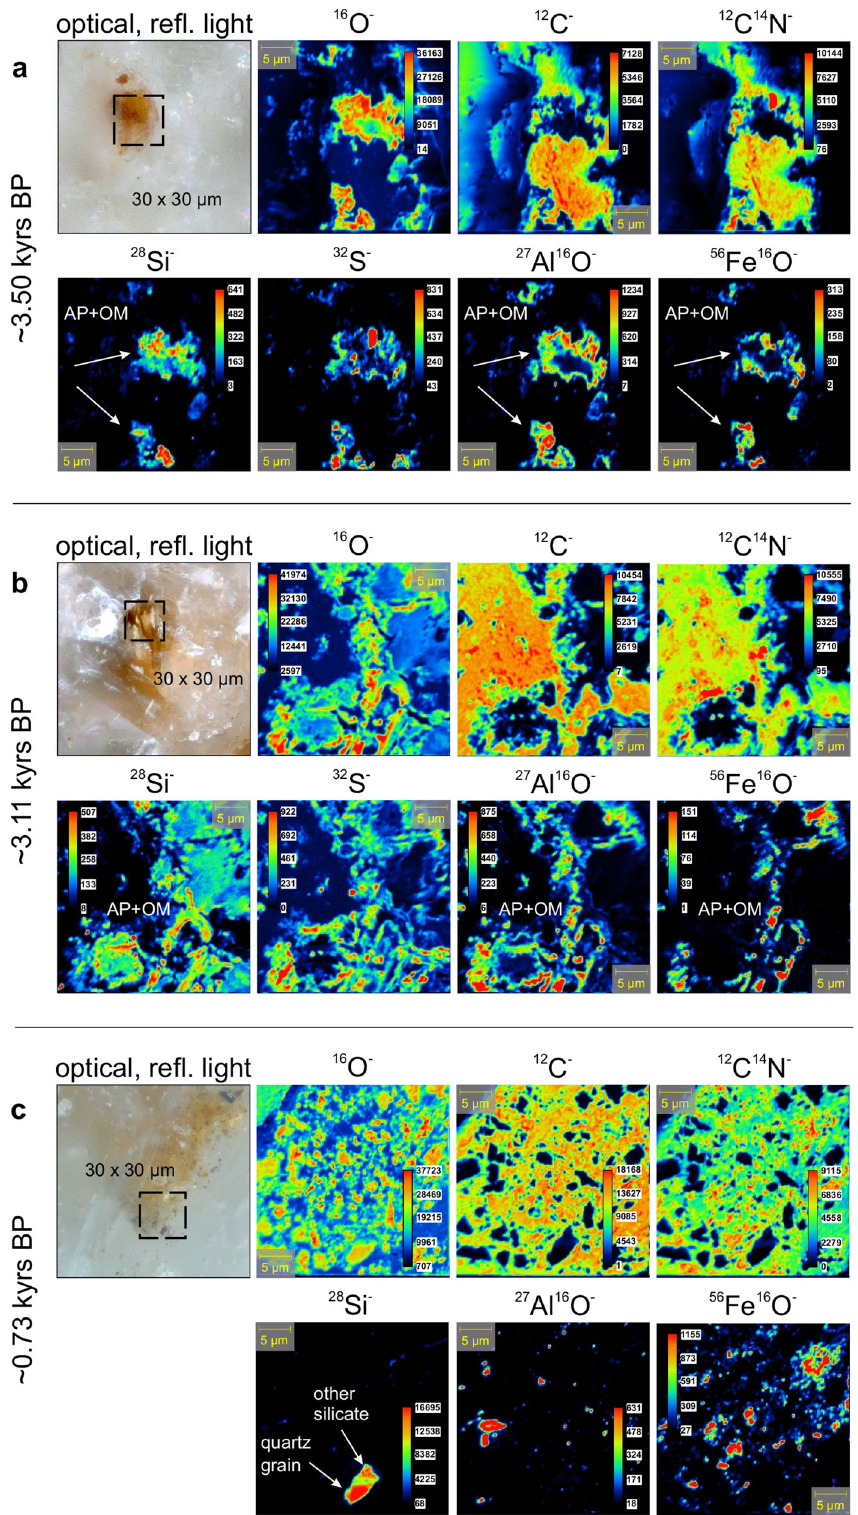
Fig. 8 NanoSIMS secondary ion mappings of detritus-rich lamina sections at ~3.50, ~3.11, and ~0.73 kyrs BP. a , b Alteration products (AP + OM) deposited during the millennium-scale acidi fi cation phase following the MB 2 eruption 1 . In both cases, at ~3.50 ( a ) and ~3.11 ( b ) kyrs BP, 16 O − , 28 Si − , 27 Al 16 O − , 56 Fe 16 O − ion counts indicate that silica gels and Al-/Fe-(hydr)oxides from the catchment were incorporated together with OM (12C − and 12C14N − ). c Bedrock-derived silicates from laminae at ~0.73 kyrs BP with signi fi cantly high 16 O − and 28 Si − secondary ion counts. Here, 27 Al 16 O − and 56 Fe 16 O − show a completely different spatial distribution compared to a , b or more intact glass shards displayed in Fig. 7.